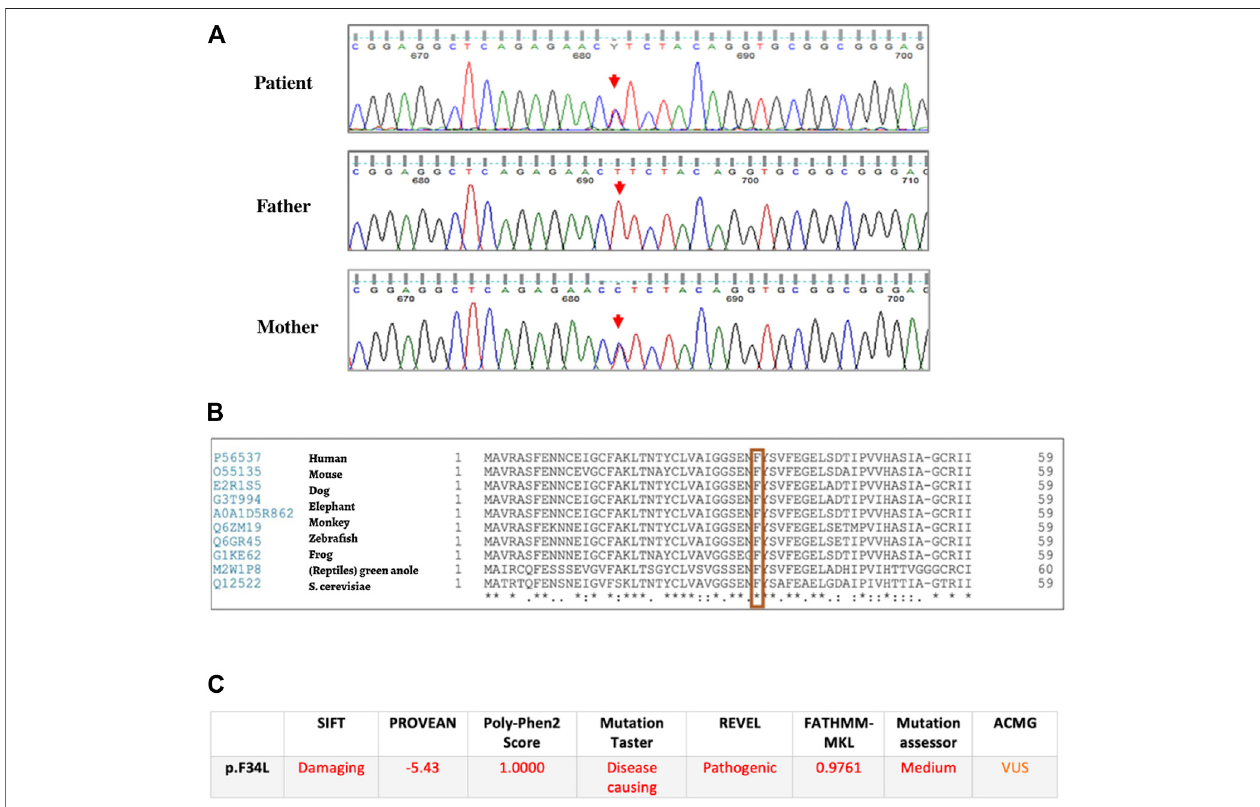
FIGURE 1 | Sequencing con fi rmation of the EIF6 variant. (A) Part of electropherogram from the proband and their parents, showing the substitution T > C in the heterozygous status at the position c.100 maternal inherited; (B) protein sequence alignment using UniProt shows absolute conservation of F34 throughout different species (human, mouse, dog, elephant, monkey, zebra fi sh, frog, reptiles, and S. cerevisiae ); (C) in silico analysis of the p.Phe43Leu variant using different prediction tools.